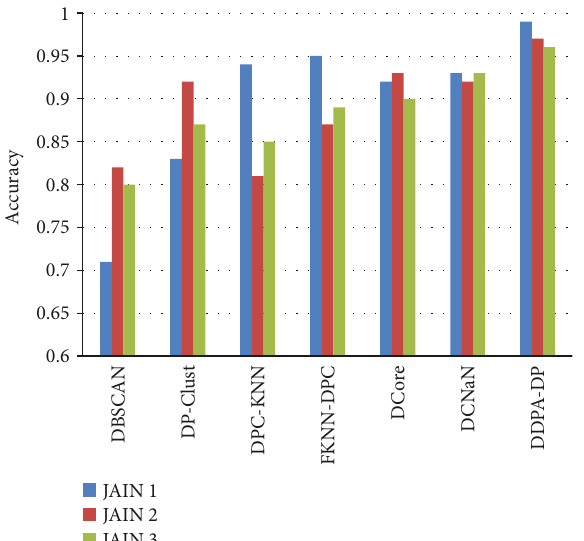
Figure 15: The simulation results in JAIN.